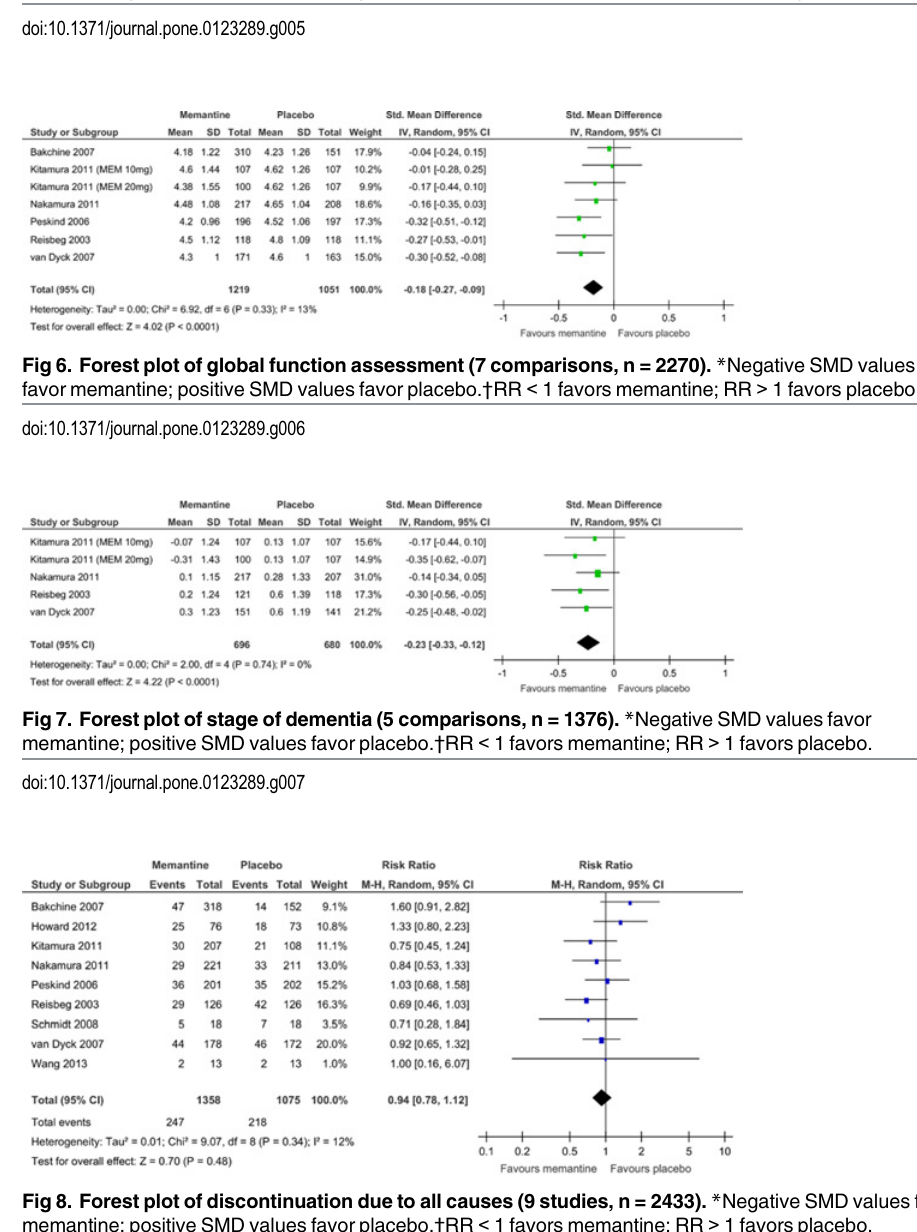
PLOS ONE | DOI:10.1371/journal.pone.0123289 April 10,